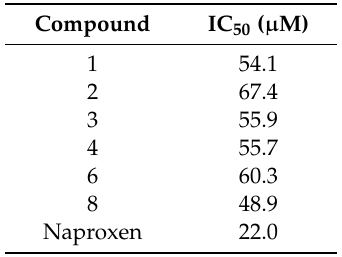
Table 1. IC 50 values for LOX